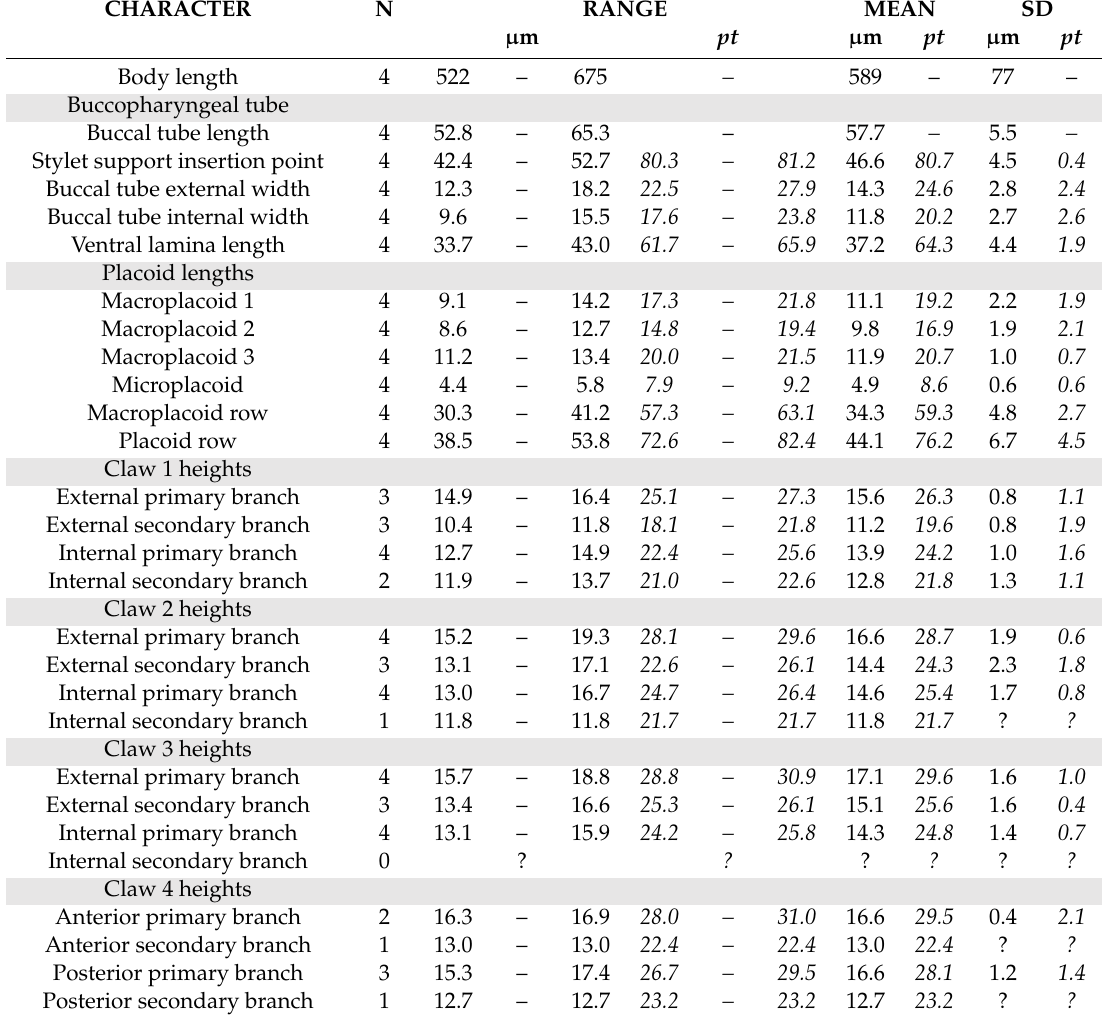
Table 9. Measurements (in µ m) and pt values of selected morphological structures of individuals of the Italian population of Paramacrobiotus fairbanksi Schill, Förster, Dandekar and Wolf [25] mounted in Hoyer’s medium (N, number of specimens / structures measured; RANGE refers to the smallest and the largest structure among all measured specimens; SD, standard deviation, pt , ratio of the length of a given structure to the length of the buccal tube expressed as a